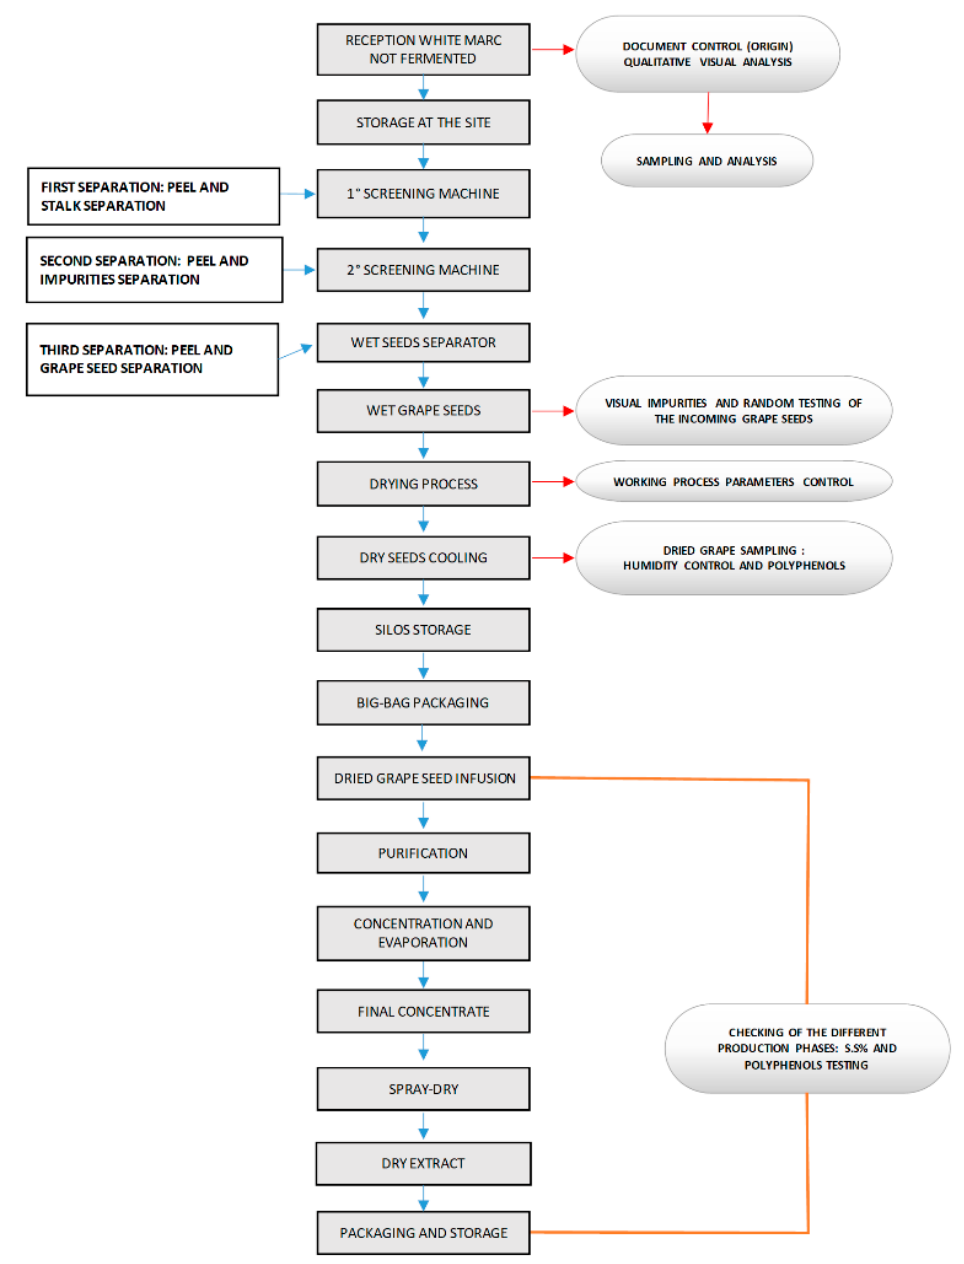
Figure 1. Flow chart of the preparation of grape seed extract (GSE) Ecovitis TM . Selected grape pomaces coming after grape pressing from prescreened Northeast Italian winemakers are immediately transferred to the production plant. Two sequential screening machines are separating seeds from peels and stalks. Seeds are then dried